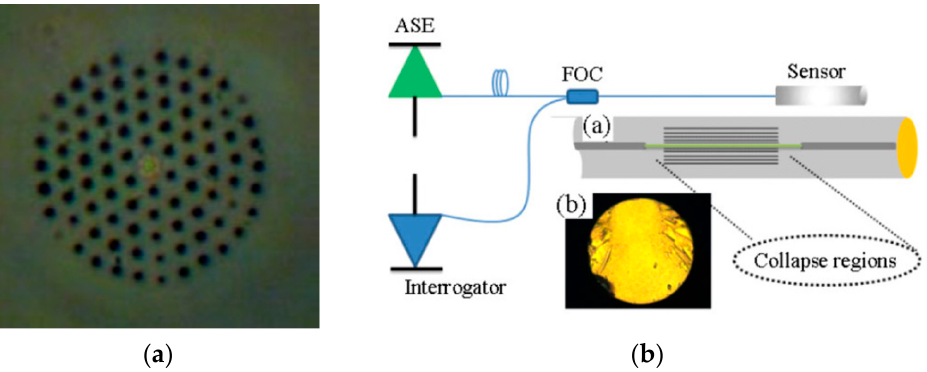
Figure 3. ( a ) cross-section of the microstructure fiber and ( b ) experimental setup with collapsed region of the microstructure fiber and gold coated at the one end of the single-mode fiber [61]. By inserting a silver nanowire into the holes of a six-hole PCF, a temperature sensor was designed based on the surface plasmon resonance effect [62]. The cross-sectional area silver nanowires and filled with the high thermos-optic coefficient liquid, a mixture of ethanol and chloroform are shown in Figure 4b. As a sensing medium, a liquid combination (ethanol and chloroform) with a high thermo-optic coefficient is injected into the PCF holes. The filled silver nanowires can sustain resonance peaks, and the peak will move when temperature changes cause changes in the mixture’s refractive indices. The temperature change may be observed by monitoring the peak shift. Because the refractive index of the filled mixture is near to that of the PCF material, the resonance peak is particularly temperature sensitive. Our numerical results show that a temperature sensitivity of up to 4 nm/K is